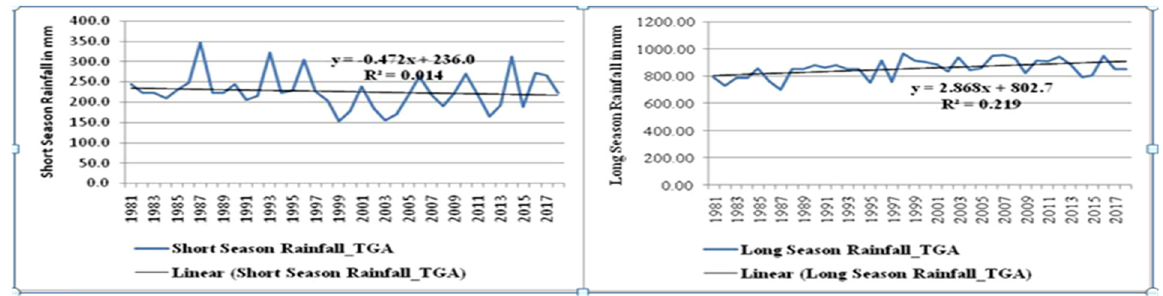
Figure 3: Trend of Short - and Long - Rainfall in te ff growing belts, 1981 – 2018. Source: Computed based on raw data from NMA of Ethiopia, 2019.